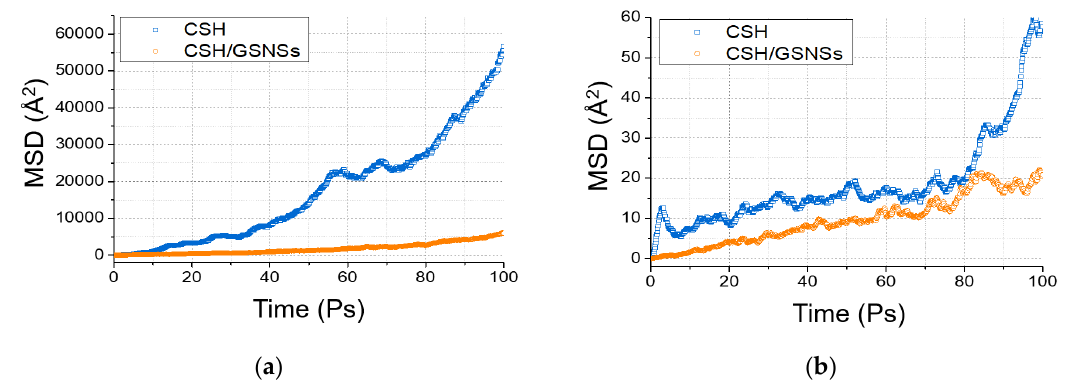
Figure 15. Mean square displacement: ( a ) water, and ( b ) calcium.